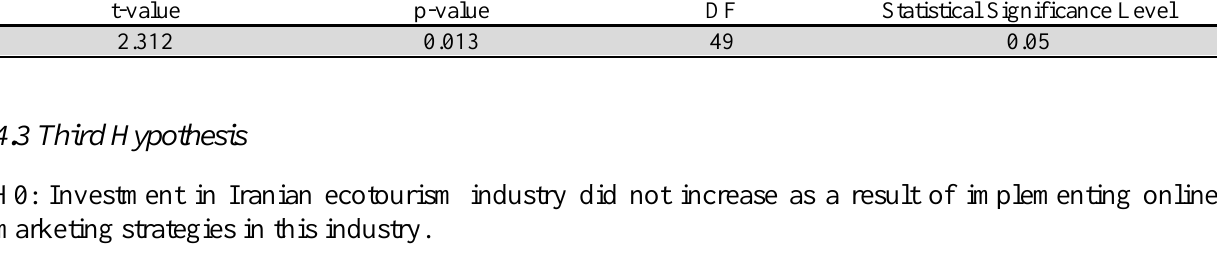
Second hypothesis at 95% confidence level t-value p-value